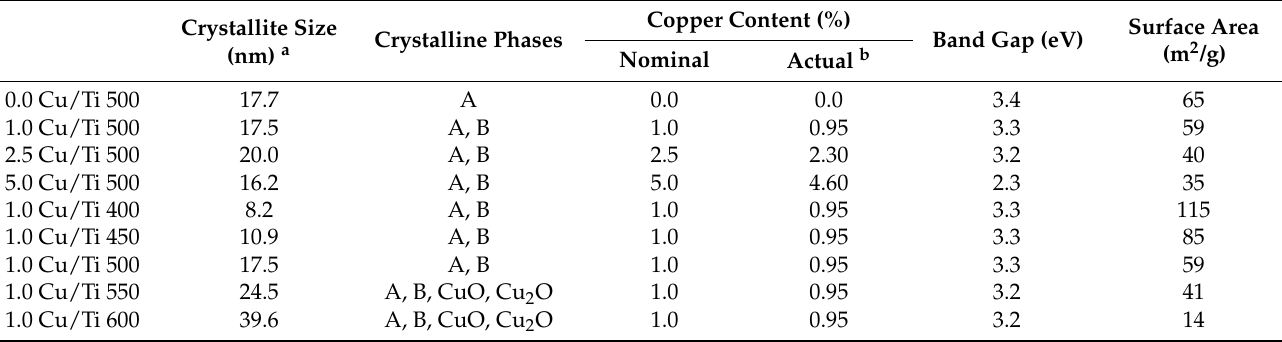
Table 1. Physicochemical properties of the Cu/Ti catalysts.